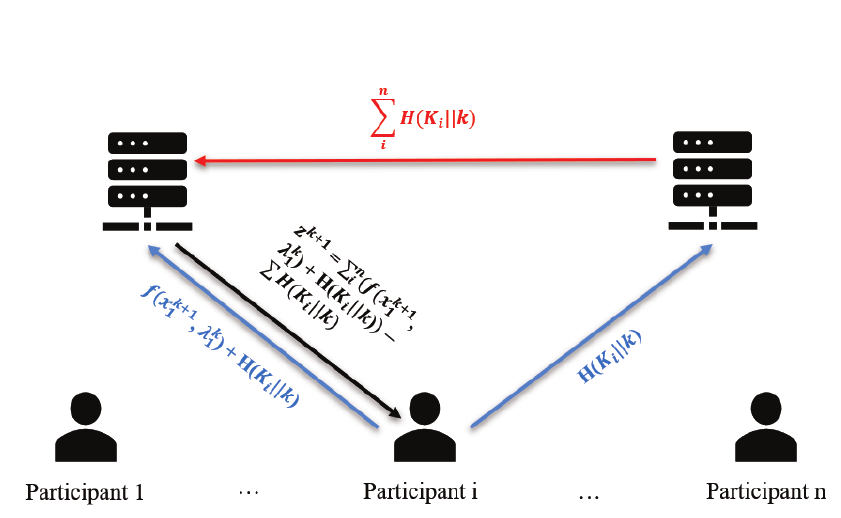
Figure 2. Privacy-preserving collaborative machine